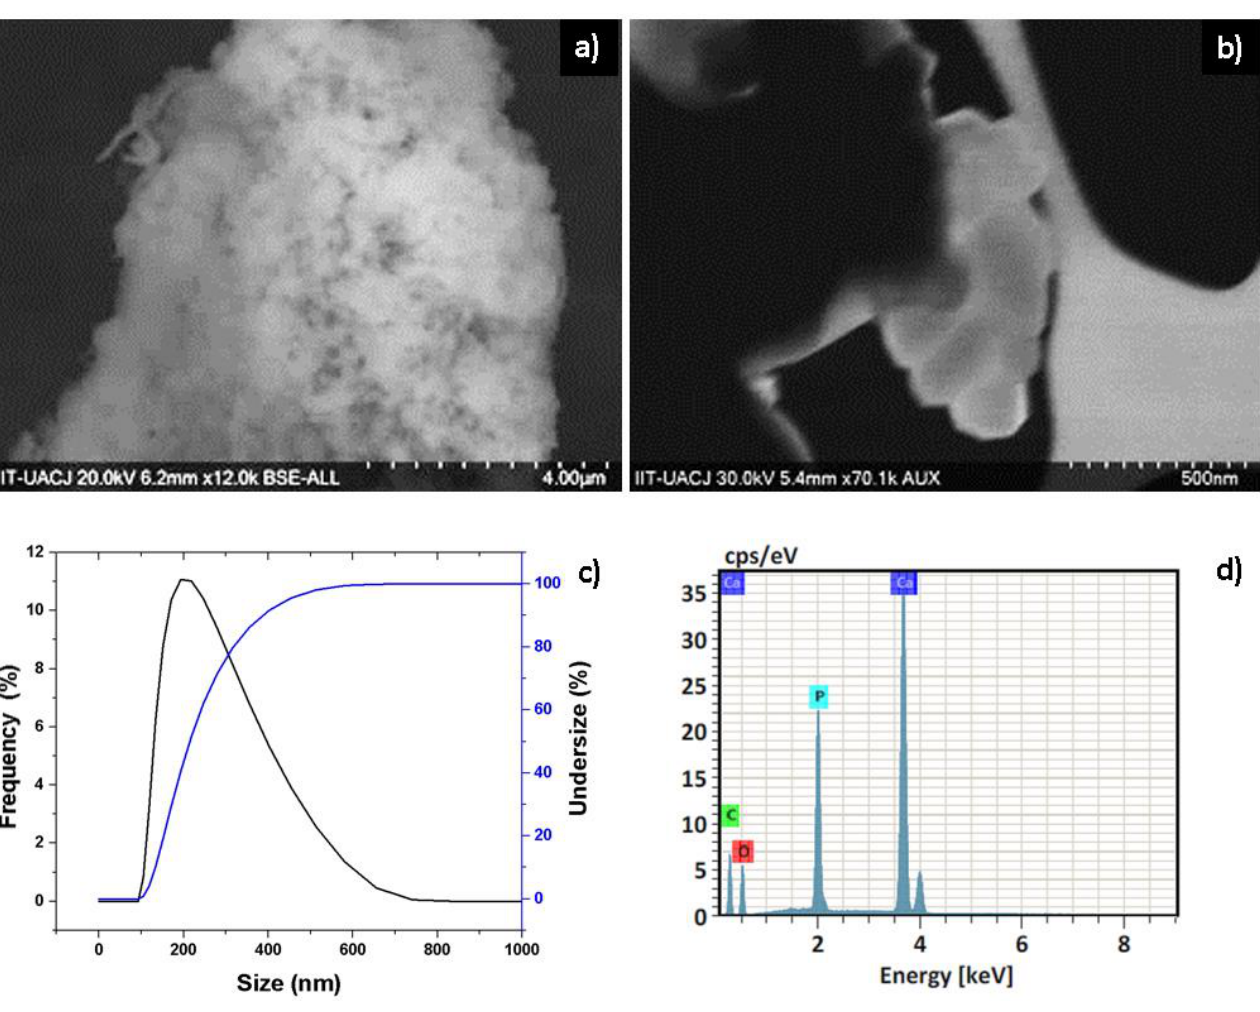
Figure 3. SEM micrographs at ( a ) 12,000 × and ( b ) 70,000 × ; ( c ) DLS and ( d ) EDX spectrum for hydroxyapatite nanopowders.